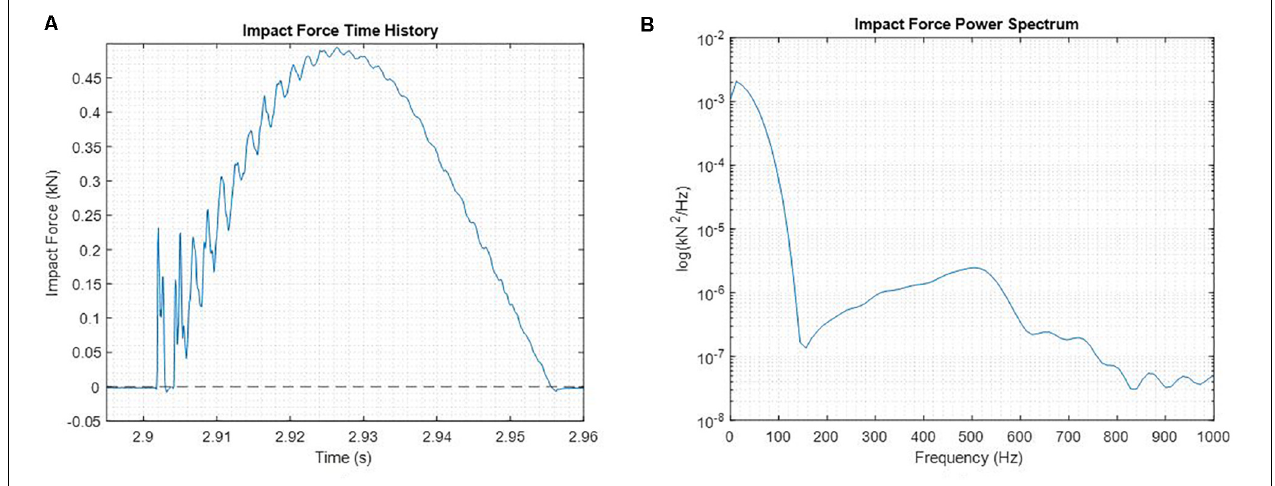
FIGURE 6 | (A) Time history of impact behavior obtained during RTHS testing of a linear impact scenario and (B) the PSD of the impact